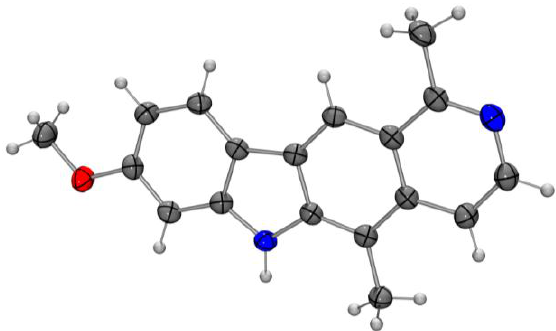
Figure 4. Molecular structure of 8-methoxyolivacine ( 19b ) in the crystal (ORTEP plot showing thermal ellipsoids at the 50% probability level).